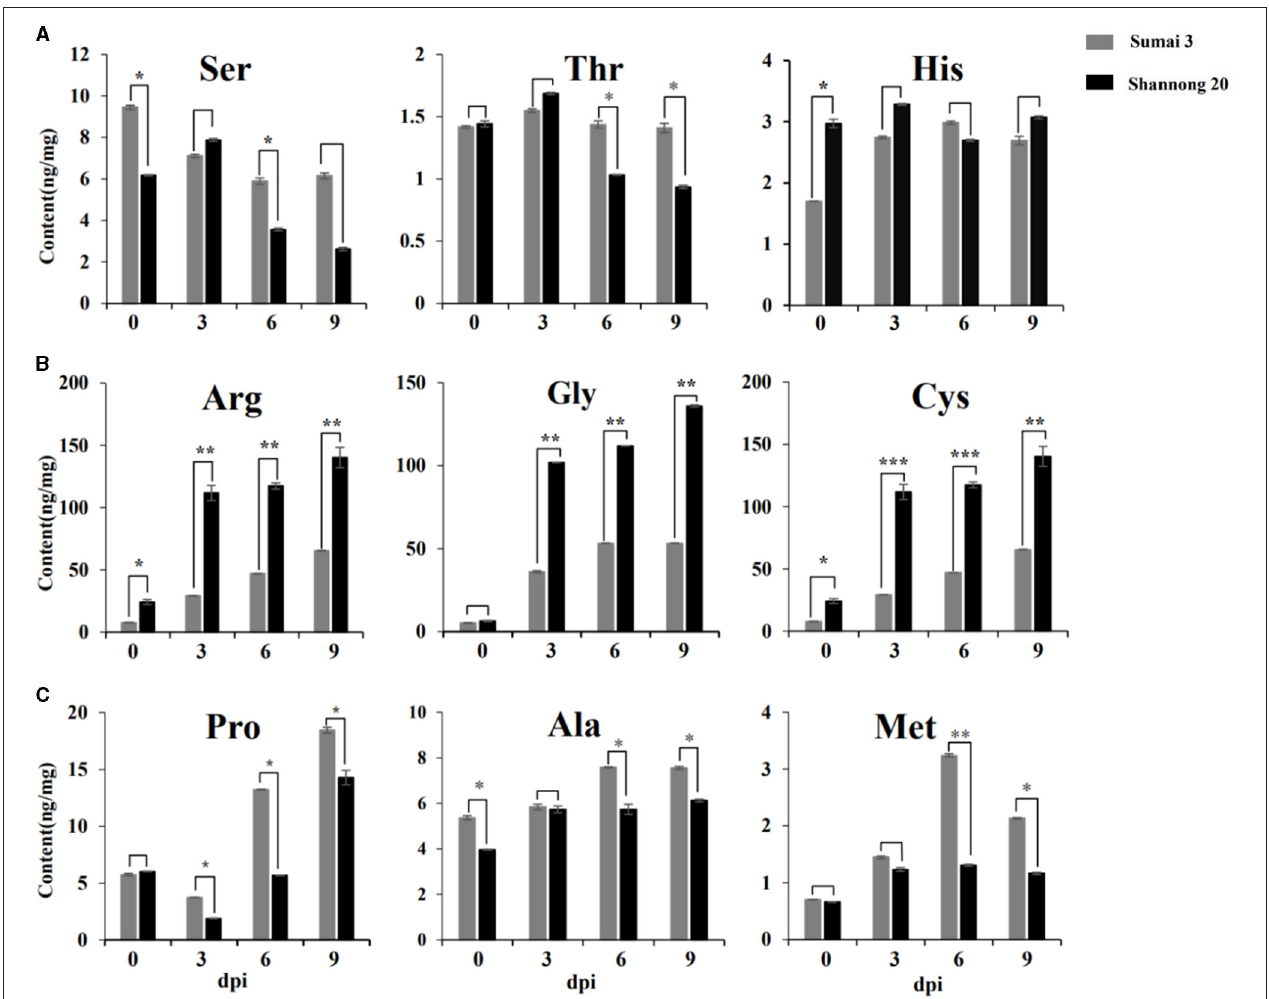
FIGURE 5 | Timeline of amino acids abundances of Sumai 3 and Shannong 20 inoculated F. graminearum . Ser, His, and Thr (A) showed no obvious rule. Arg, Cys, and Gly (B) and Pro, Met, and Ala (C) exhibited increased levels in Sumai 3 and Shannong 20 after F. graminearum treatment. The contents of Arg, Gly, and Cys were higher ( P value < 0.01) in Shannong 20 than in Sumai 3 at 3, 6, and 9 dpi. The contents of Pro, Ala, and Met were higher ( P value < 0.05) in Sumai 3 than in Shannong 20 at 6 and 9 dpi. Student’s t -test P -value: *** P value < 0.001, ** P value < 0.01, * P value <